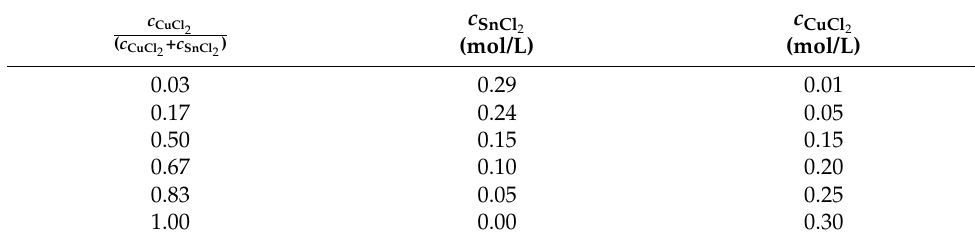
Table 1. Electrolyte